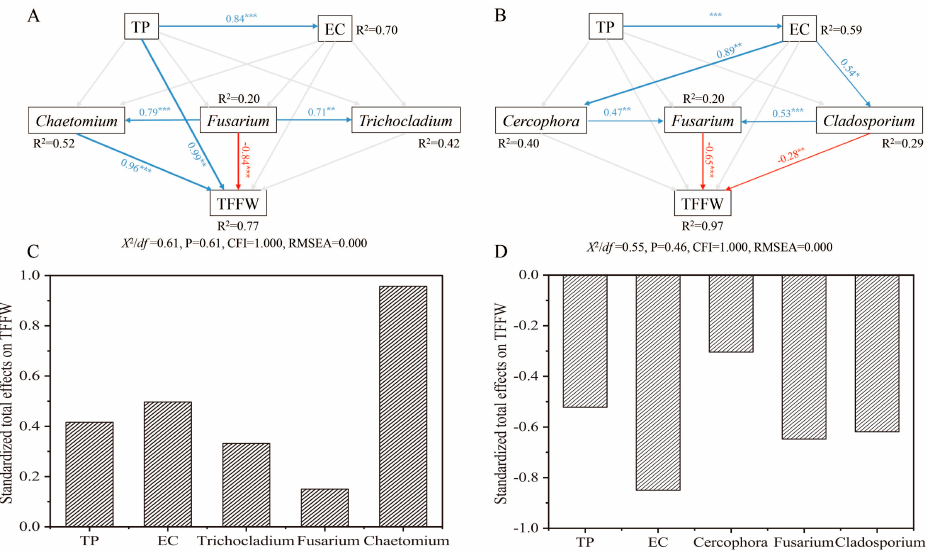
Figure 6. Structural equation models (SEM) based on the effect of soil chemical properties (EC, TP), soil fungal genera ( Fusarium , Chaetomium , Trichocladium , Cercophora and Cladosporium ) on TFFW under different CTM cycles. ( A ) SEM among CTM1, CTM3, CTM5 and CTM9. ( B ) SEM among CTM3, CTM5, CTM9 and CTM13. ( C ) Standardized total effects among CTM1, CTM3, CTM5 and CTM9. ( D ) Standardized total effects among CTM3, CTM5, CTM9 and CTM13. Blue and red arrows indicate significant positive and negative correlations, respectively. Gray arrows indicate no significant correlations. The width of the arrows indicates the strength of the correlations. Numbers at the arrows represent standardized path coefficients. R 2 indicates the proportion of variance explained by the model. *** p < 0.001; ** p < 0.01; * p < 0.05.